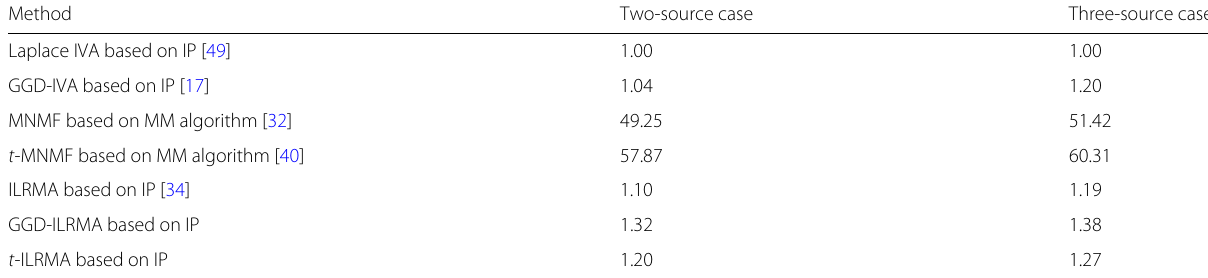
Table 10 Relative computational times normalized by Laplace IVA based on IP, where the length of the observed signal is 10 s